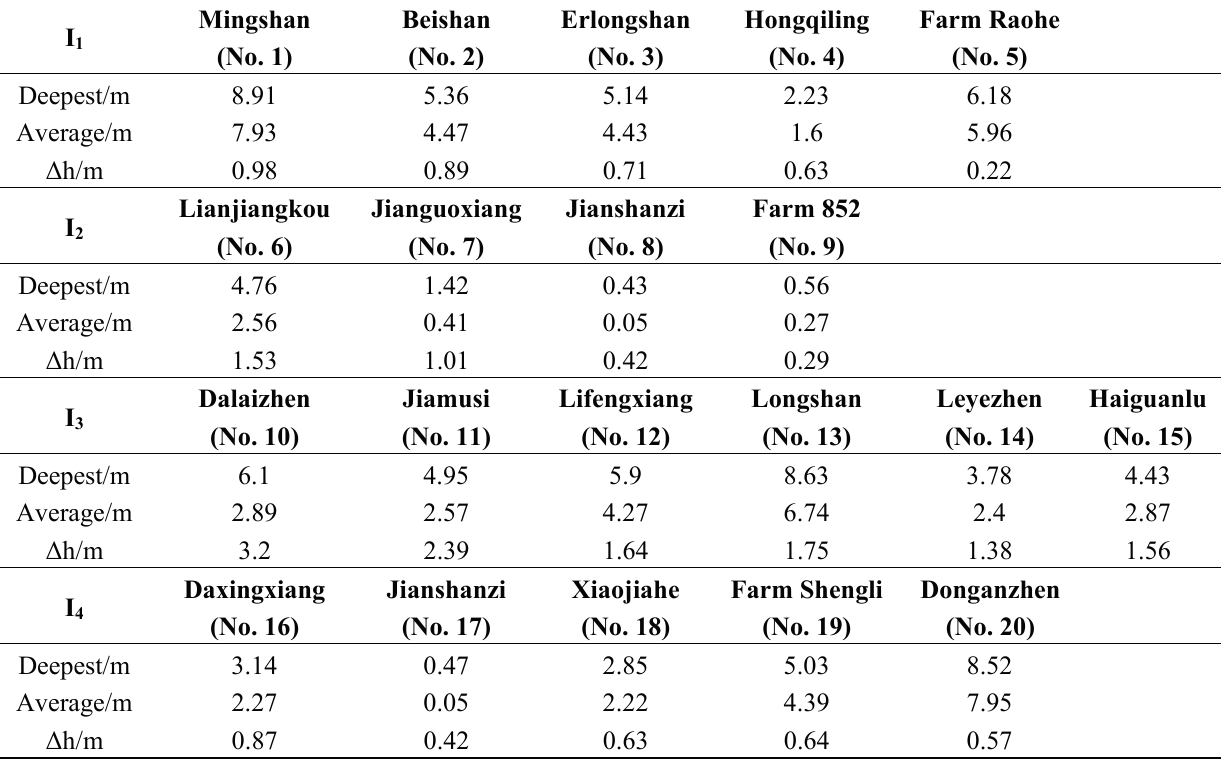
( a ) ( b ) Figure 3. Shallow groundwater depths pre- ( a ) and post- ( b ) 2013 summer flood in the Sanjiang Plain, Northeast China. Table 1. Changes of groundwater depth along four cross-sections in the Sanjiang Plain, Northeast China after the 2013 summer